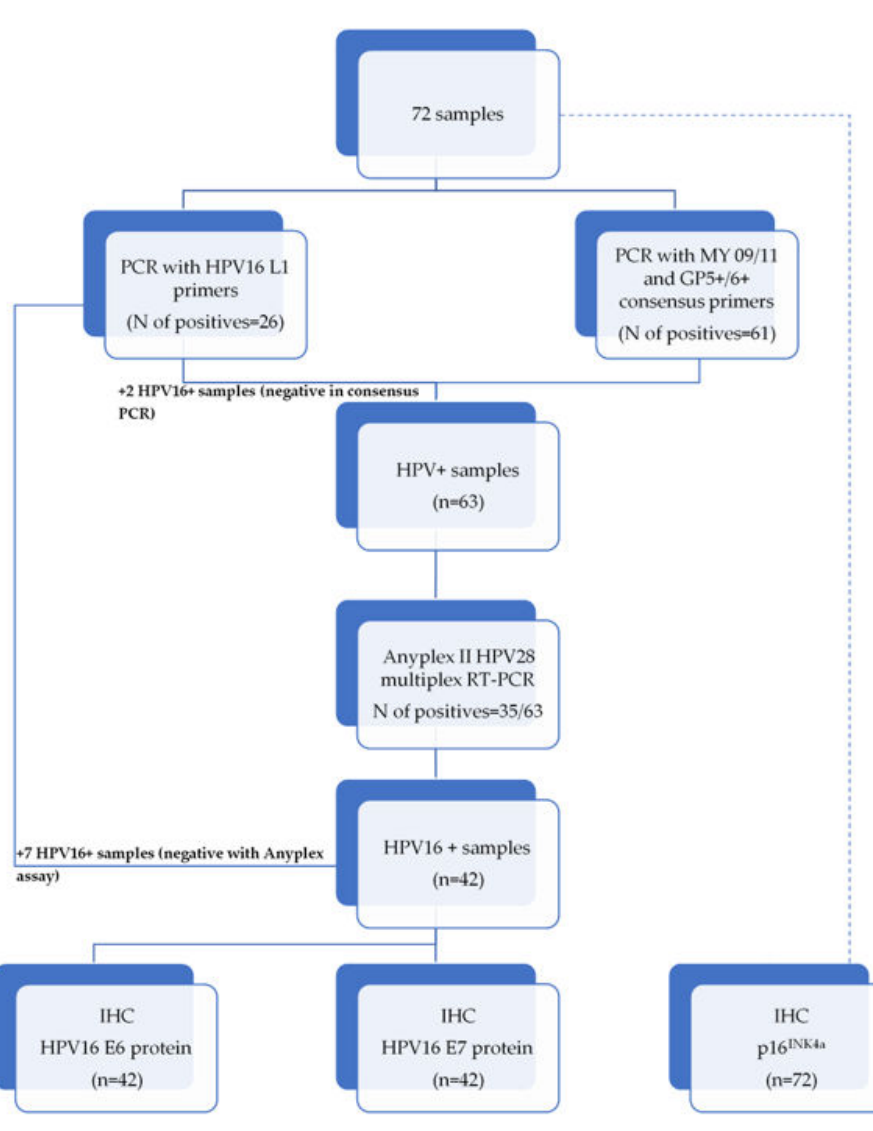
Figure A1. The workflow scheme of the